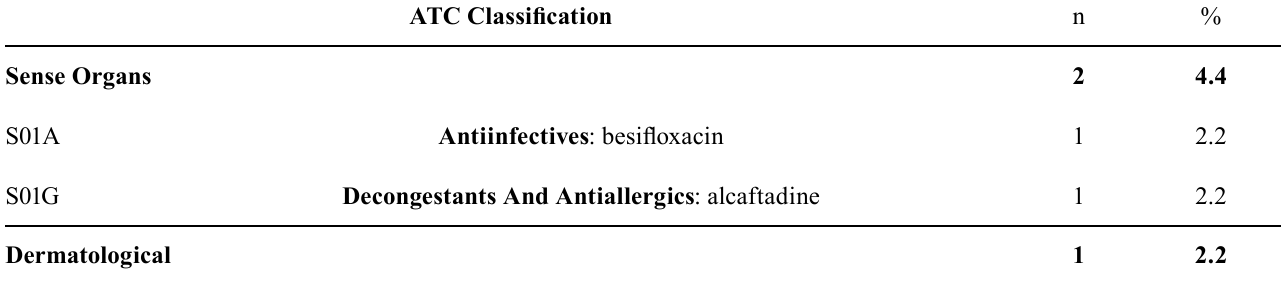
TABLE I – Anatomical Therapeutic Chemical Classification of the 46 pediatric drugs identified in the cohort of new drugs